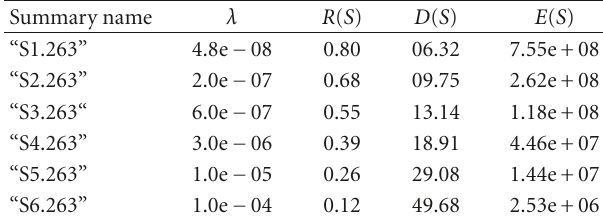
Table 2: Energy-summary quality tradeo ff subjective